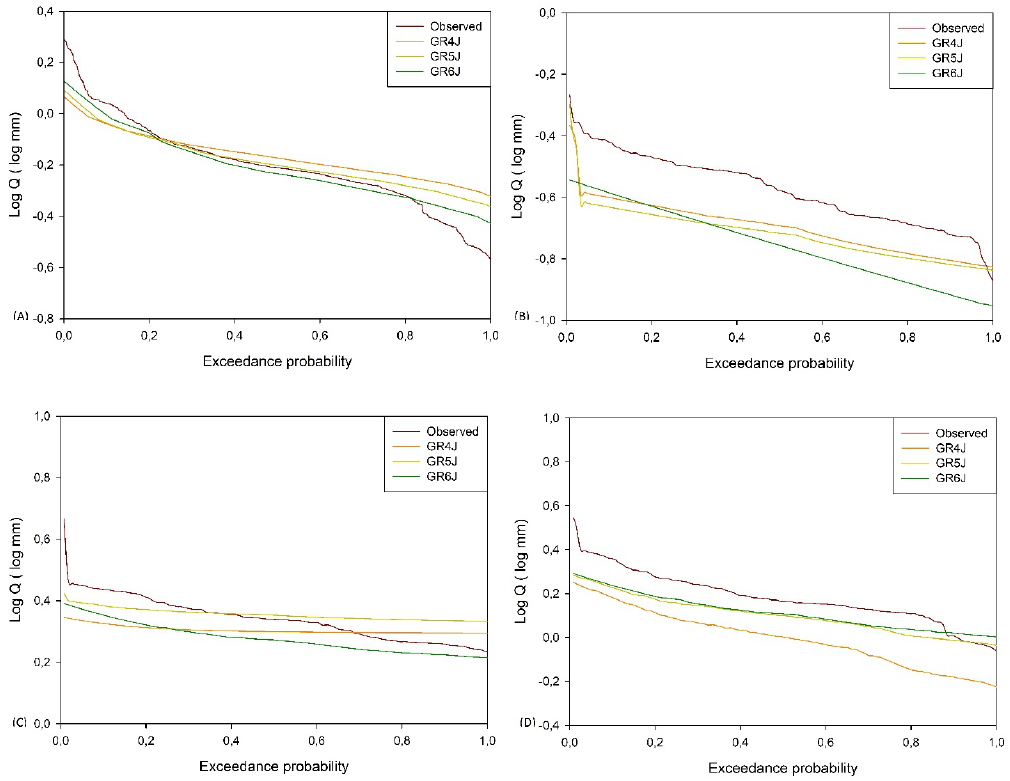
Figure 8. Low-flow exceedance probability curves for observed and simulated values by the GR4J, GR5J and GR6J hydrological models in the calibration period for: Q2 ( A ), Q3 ( B ), BlQ1 ( C ) and BLQ2 ( D ), in south-central Chile.